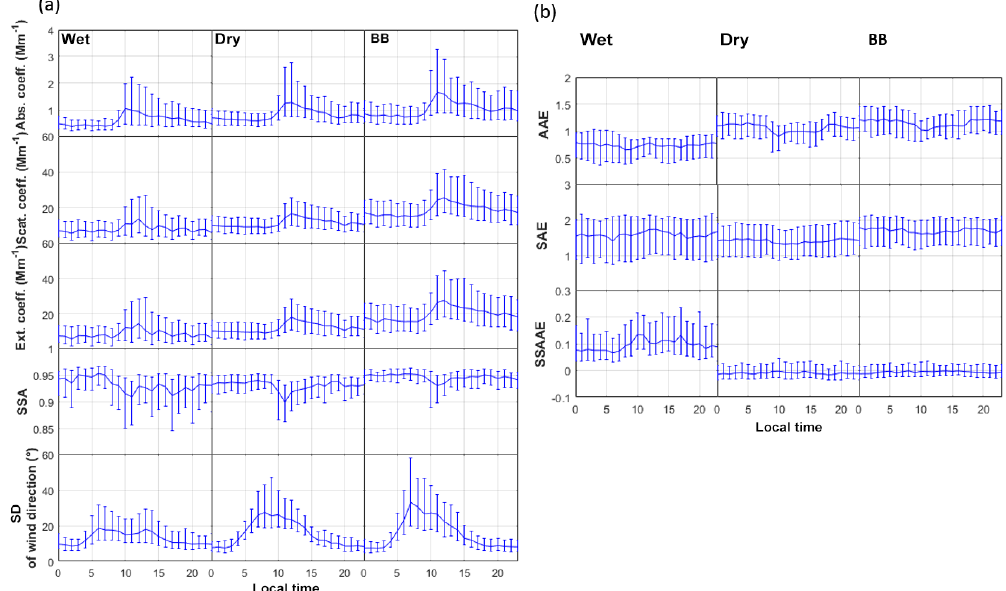
Figure 6. Hourly medians (with 25th and 75th percentiles) of (a) the absorption coefficient, the scattering coefficient, the extinction coeffi- cient, the single scattering albedo at 500 nm, and the standard deviation (SD) of the wind direction and of (b) the AAE, SAE, and SSAAE measured at the CHC station for each